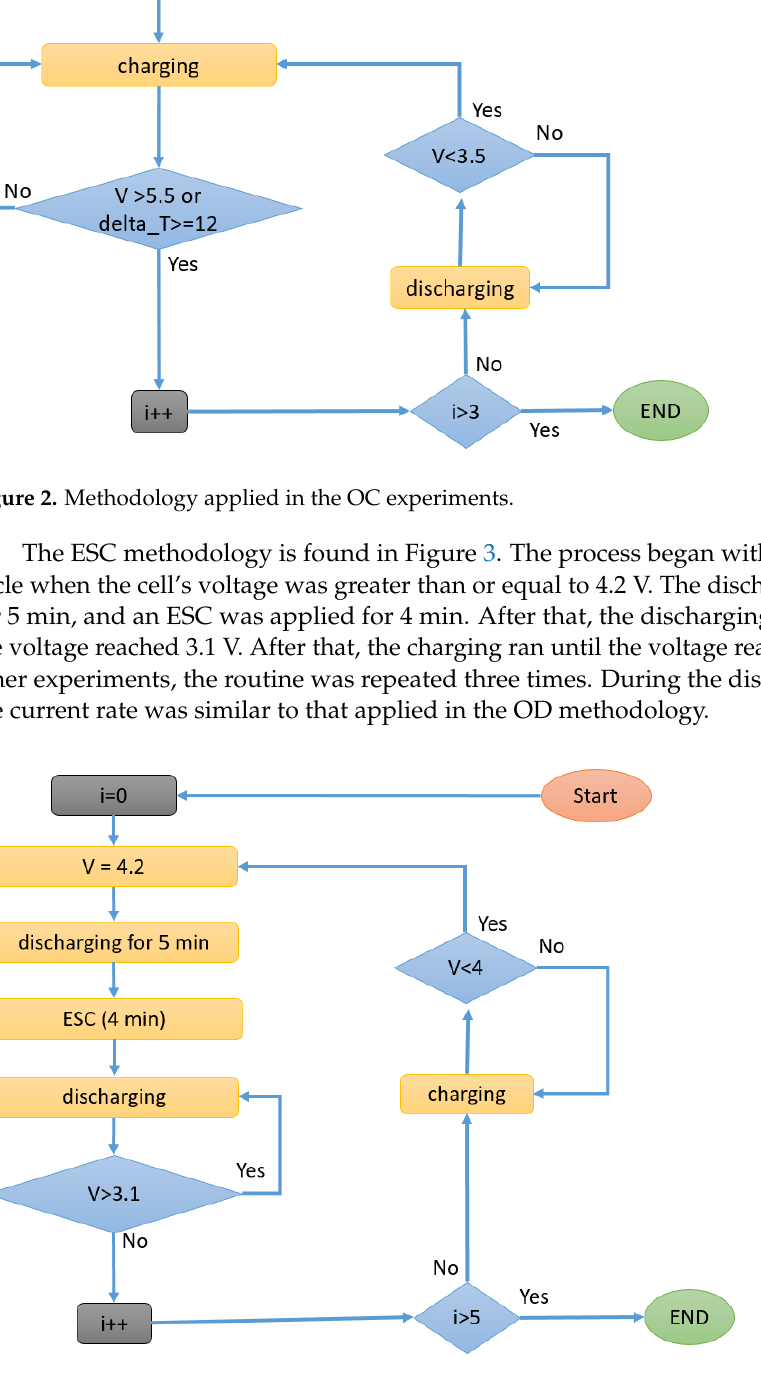
Figure 3. Methodology applied in the ESC